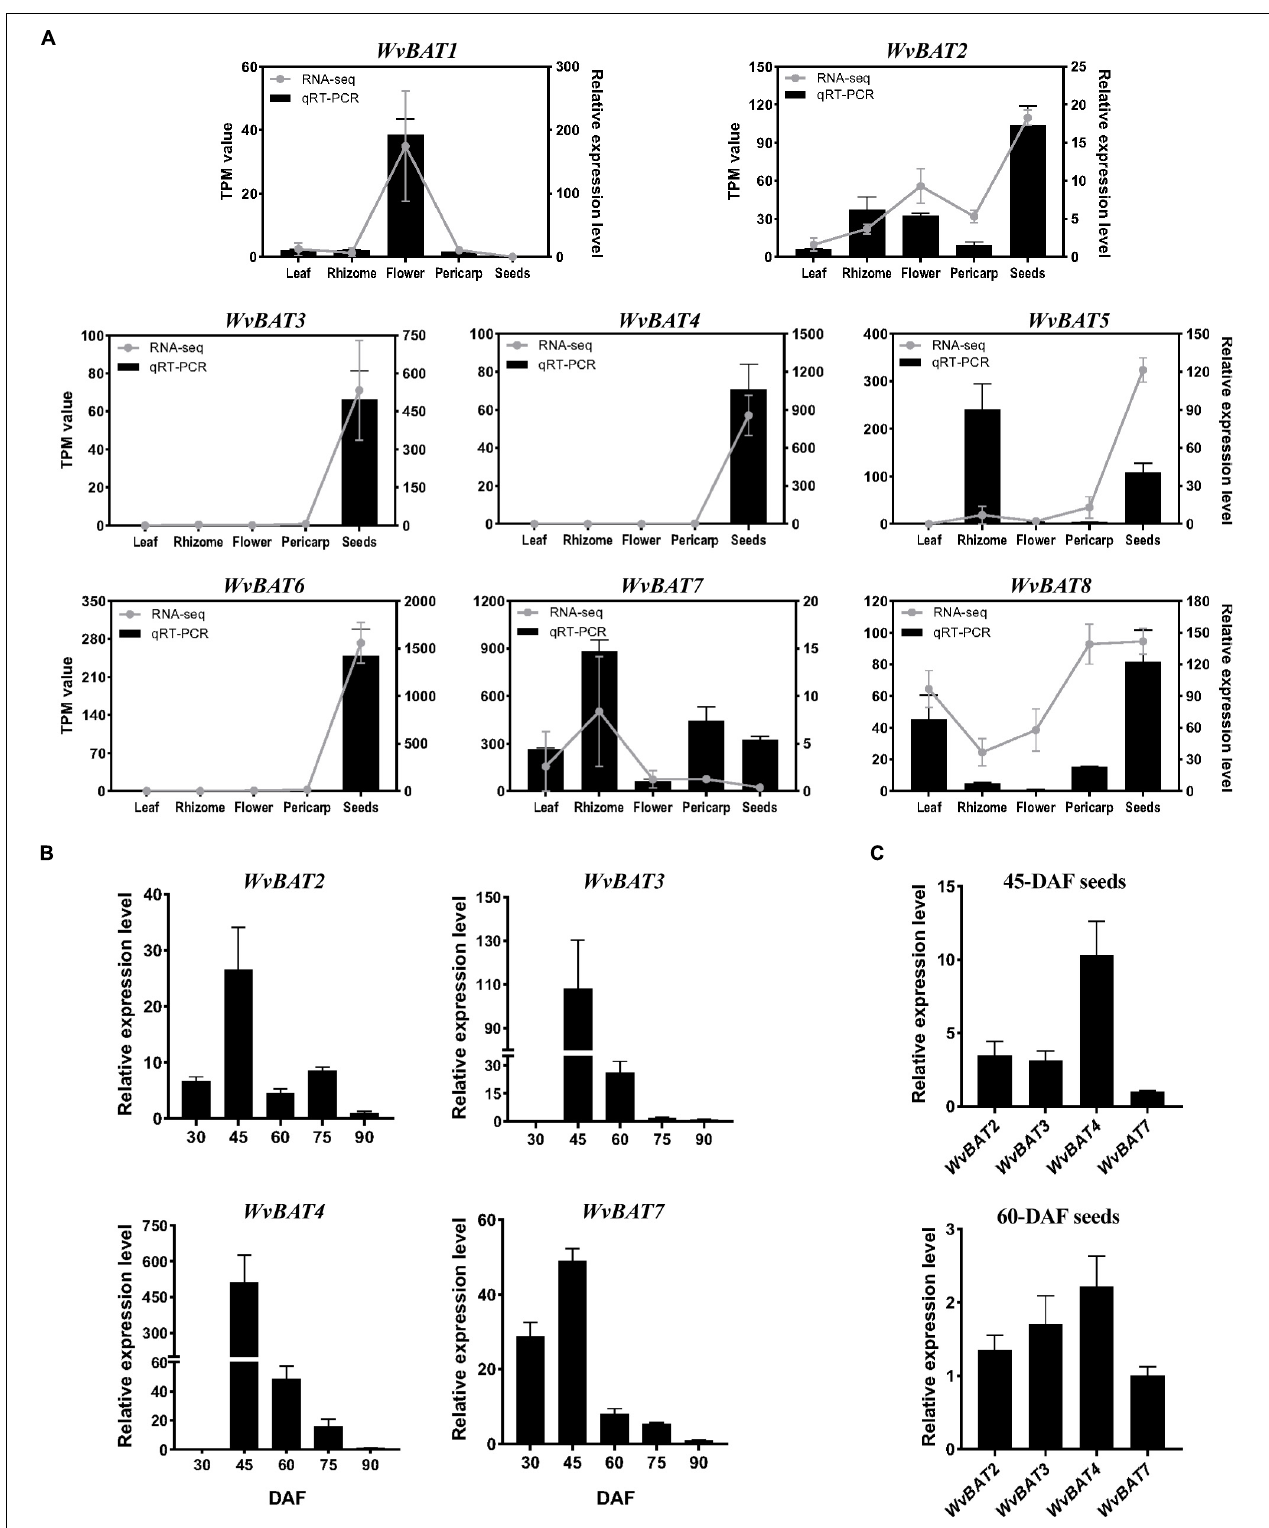
FIGURE 7 | Expression pattern of WvBATs . (A) The relative expression levels of WvBATs in different tissues. Pericarp and seeds were from 60-days after flowering (DAF) fruits. Transcripts per million reads (TPM) value was from the RNA-sequencing (RNA-seq) data. Comparison of the expression levels of the WvBATs , capable to catalyze (+)-borneol, in seeds at different developmental stages (B) or at the same stage, 45-DAF or 60-DAF (C) . Data represent the means ± SDs ( n = 3).